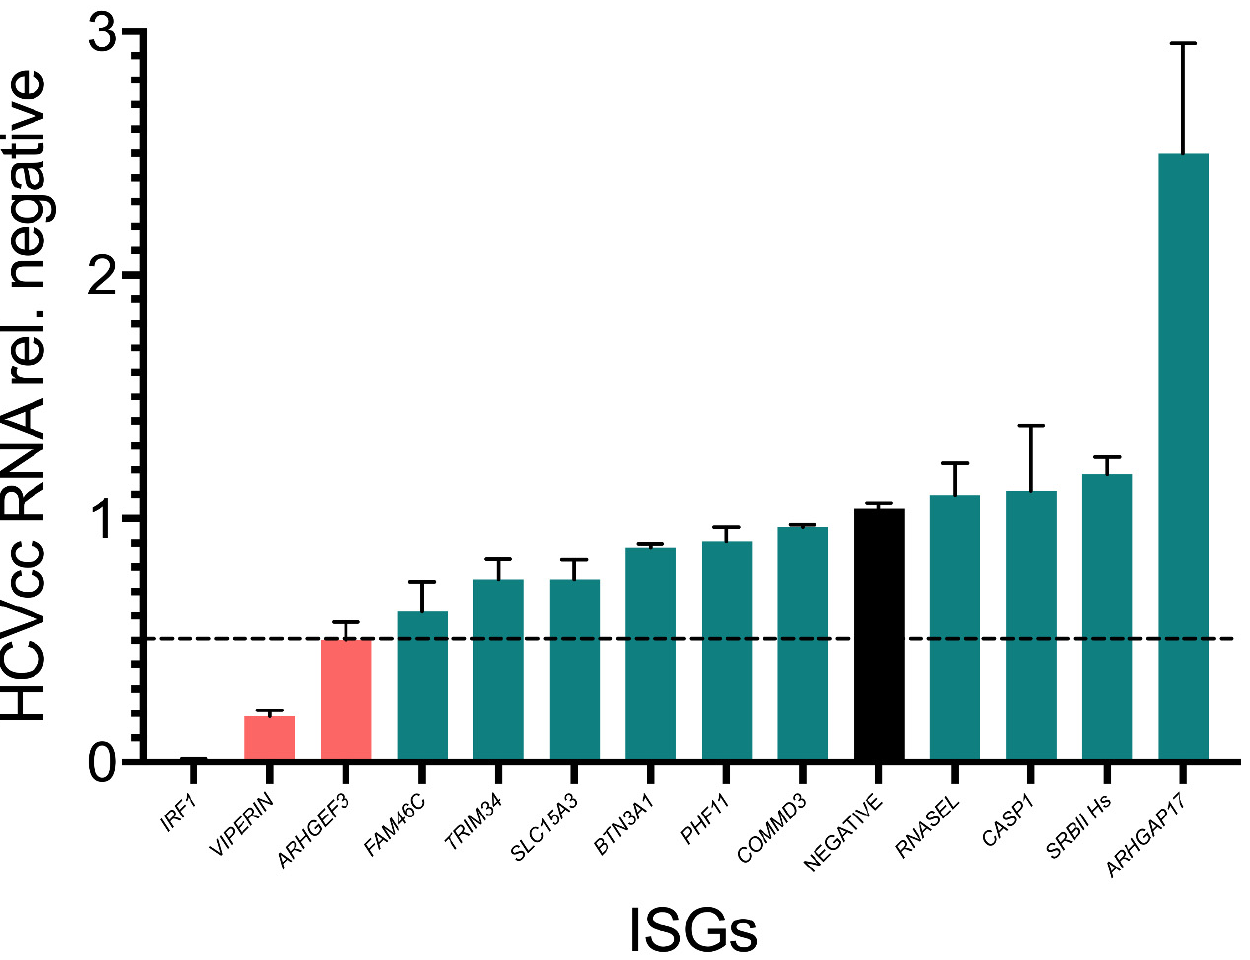
Figure 3. Validation of ISGs with activity against HCVcc. The effect of ISG expression on replication of full-length Jc1-HCVcc was ascertained following infection of stably transduced ISG-expressing cell lines by quantification of HCV viral RNA abundance by RT-qPCR at 72 hpi (moi = 0.1). Negative controls are shown (black) and ISGs that reached a threshold of >2-fold reduction in viral replication are shown in pink. ISGs that do not achieve this threshold are shown in green. Values from combined duplicate technical replicates from three independent experiments were used and variation is shown as standard error of the mean.